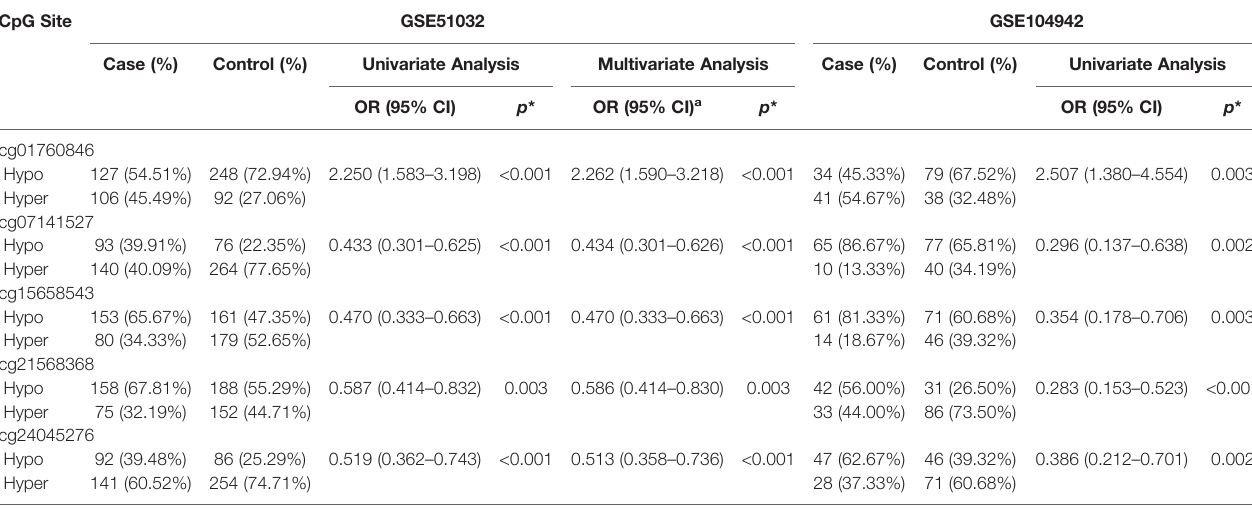
TABLE 1 | The association between methylation of fi ve CpG sites and the risk of BC in